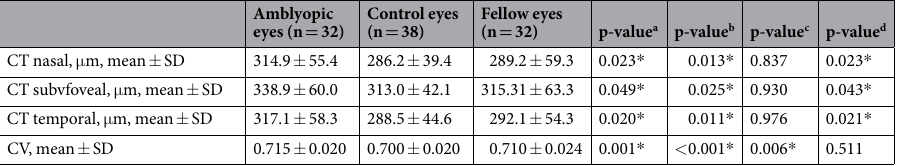
Table 2. Comparisons of choroidal thickness and vascularity between groups. CT: choroidal thickness; CV: choroidal vascularity; SD: standard deviation. a Kruskal Wallis test between Amblyopic eyes, fellow eyes, and controls. b Mann-Whitney test between amblyopic eyes and controls. c Mann-Whitney test between fellow eyes and controls. d Mann-Whitney test between amblyopic eyes and fellow eyes. * Statistically significant